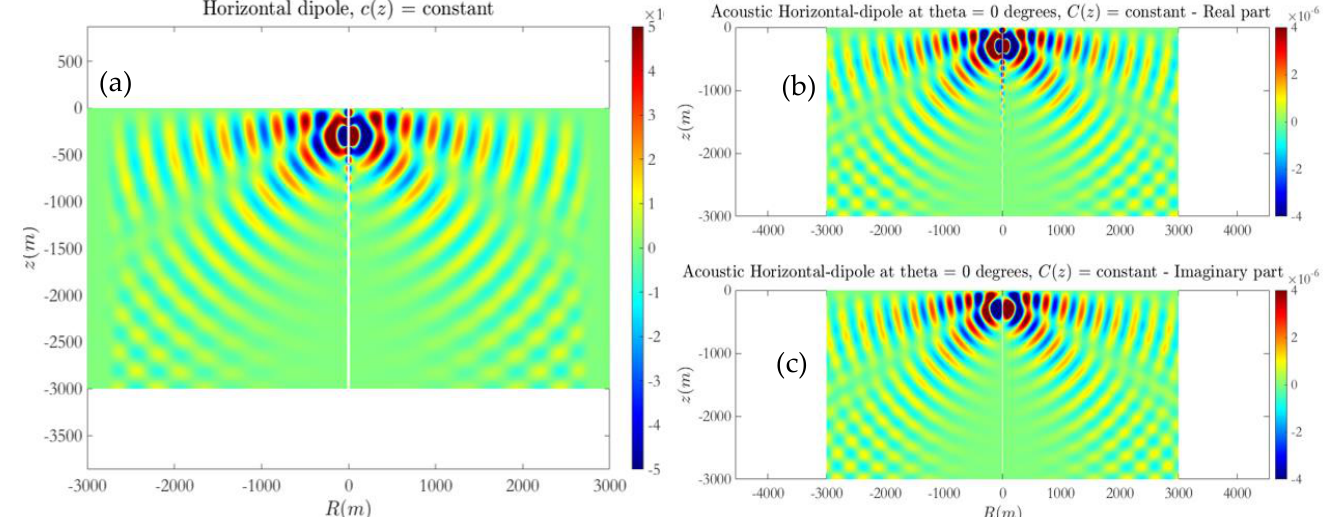
Figure 9. ( a ) The calculated acoustic field for the isovelocity environment, obtained using the present FDTD–PML numerical scheme, excited by a horizontal dipole source of frequency f = 5 Hz located at a depth of 300 m, at the end of the computation time after 15 periods. ( b , c ) Real and imaginary parts of the acoustic field obtained using the solution of the Helmholtz equation excited by a horizontal dipole source of frequency f = 5 Hz located at a depth of 300 m.